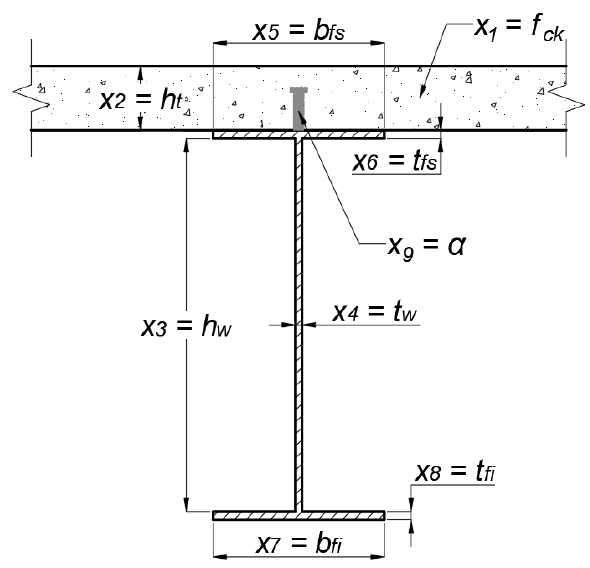
Figure 4. Variables of the optimization problem.